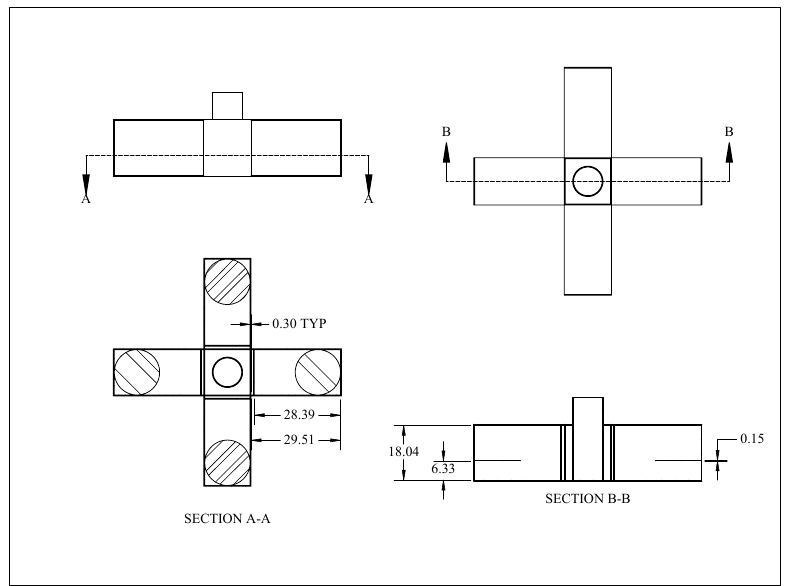
Figure 21. Drawing of the internal geometry of the